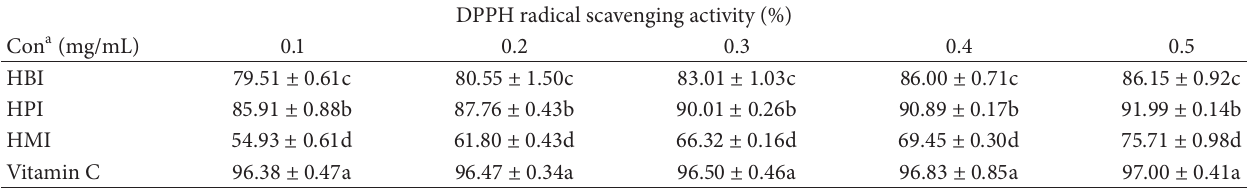
Table 2: DPPH radical scavenging activities of vitamin C, HMI, HPI, and HBI. Each value is the mean ± SD.